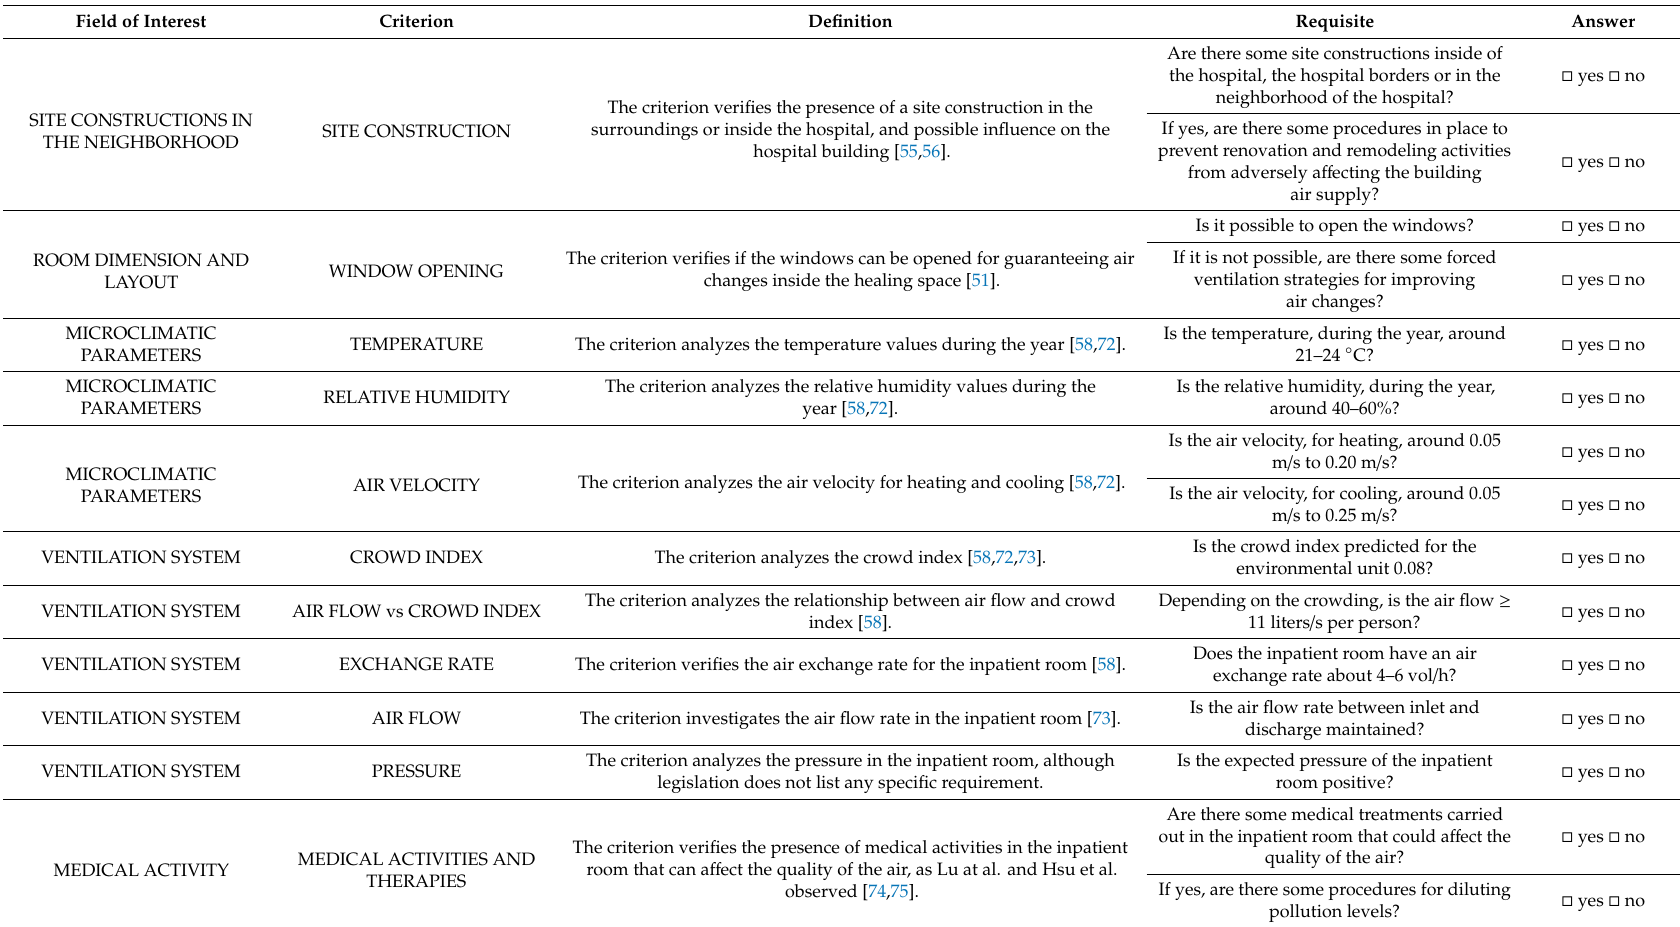
Table 3. Check-list for daily